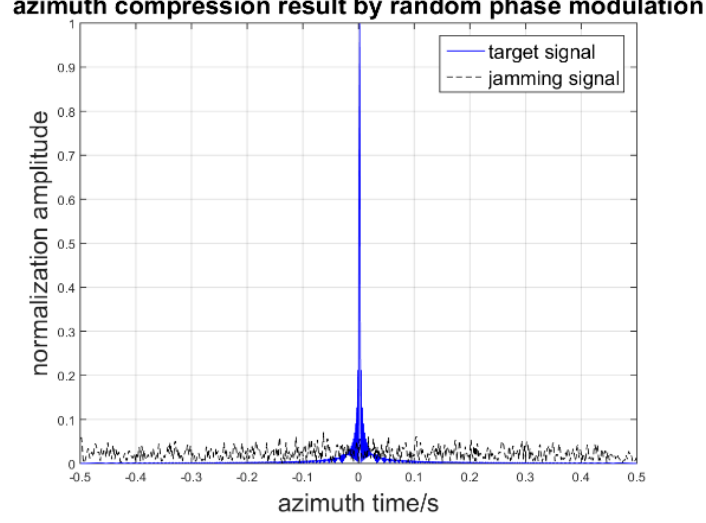
Figure 9. Azimuth compression result of target and jamming.